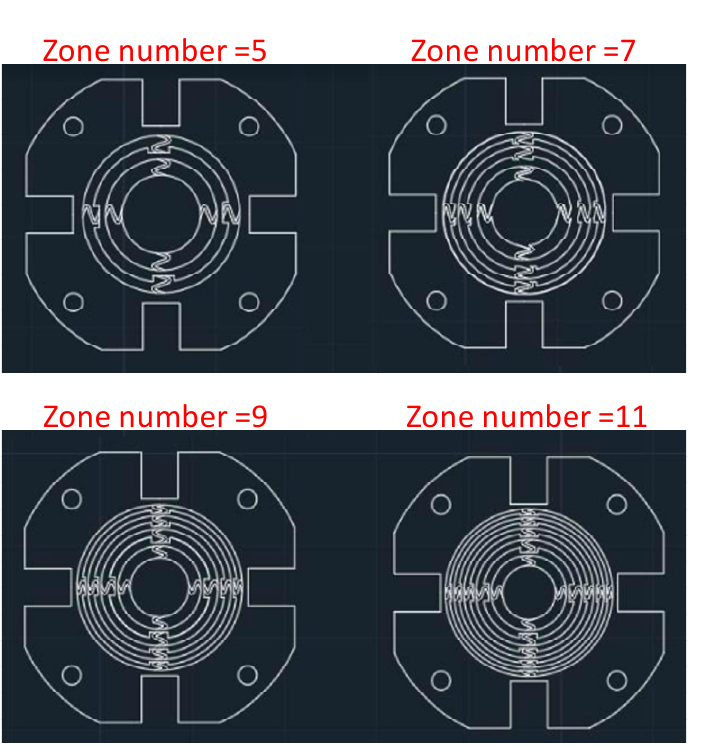
Figure 5. Photomask designs of the stretchable zone plate with zone number 5, 7, 9 and 11.